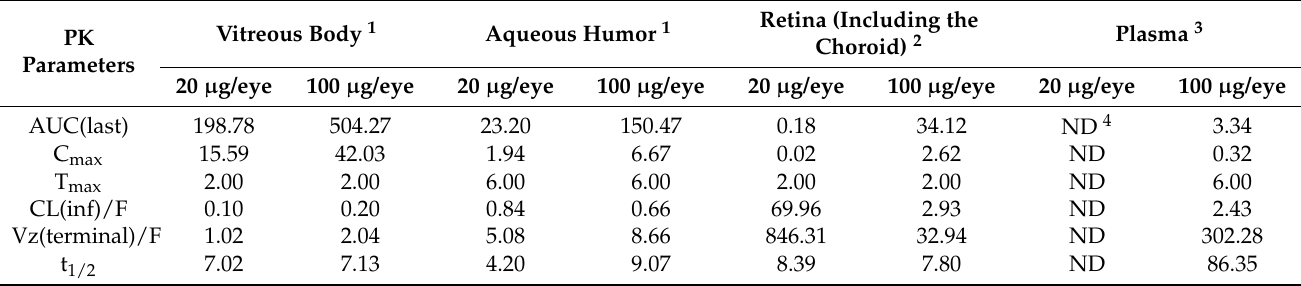
Table 1. Pharmacokinetic parameters of Ac-RLYE following single intravitreal administration in